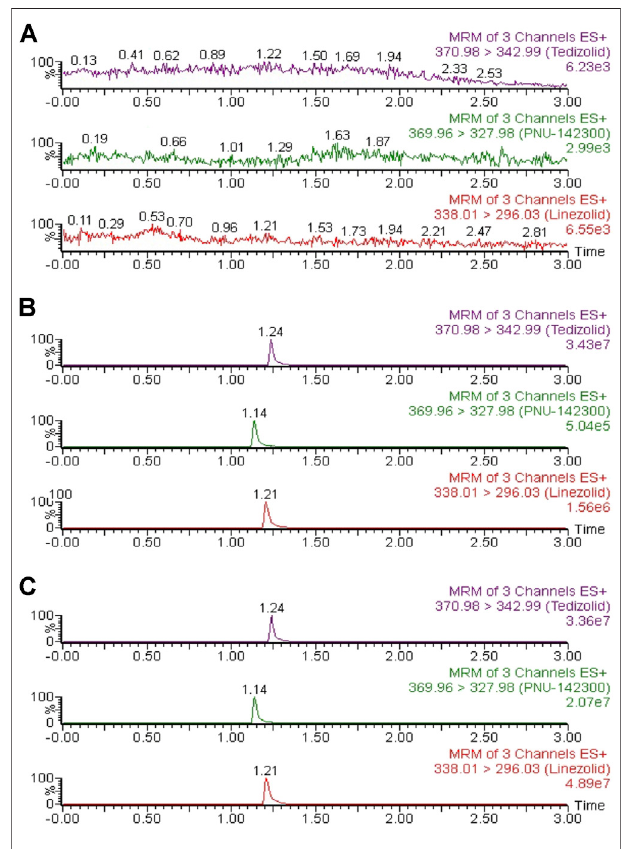
FIGURE 2 | Representative chromatograms of linezolid, PNU-142300, and IS in human serum: (A) blank serum; (B) blank serum spiked standard solutions (1.0 μ g/ml forlinezolid and IS, 2.0 μ g/ml for PNU-142300); (C) areal human serum.